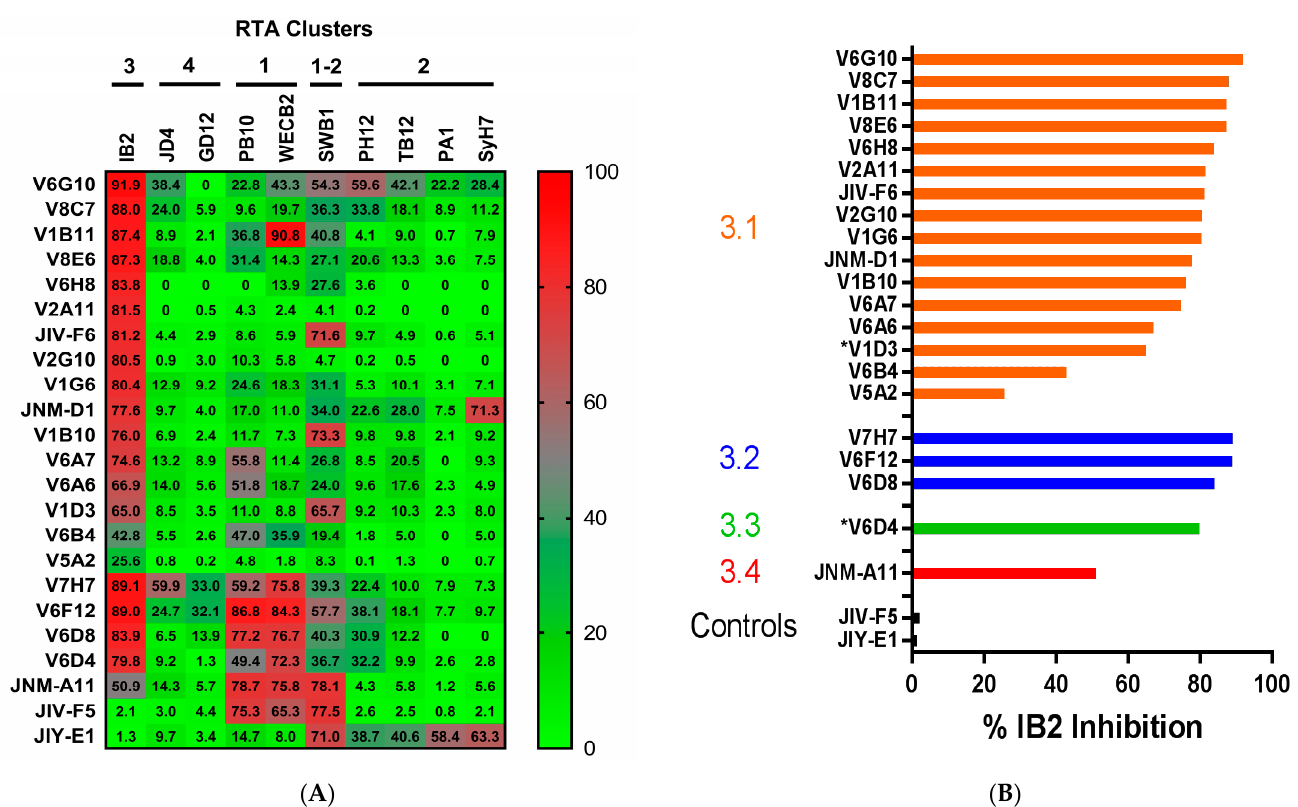
Figure 2. V H H binning by competition ELISA. ( A ) Ricin was captured on microtiter plates by anti-RTA mAbs (indicated along the top panel) or an anti-RTB mAb (SylH3) as a control. The plates were then probed with individual V H Hs as indicated on the left most column and detected with a secondary E-tag antibody. Binding inhibition was calculated as 100 − (100 × (A mAb-Ricin /A SylH3-Ricin )) where interference by SylH3 was assumed to be negligible. The colored scale bar on far right indicates % inhibition. V H Hs JIV-F5 and JIY-E1 were used as controls, since they are known to bind epitopes on RTA outside of IB2’s footprint. ( B ) The IB2 values from panel A are re-plotted for clarity to compare relative IB2 inhibition values and color coded based on subcluster designations described later in the manuscript. The two V H Hs with toxin-neutralizing activity are denoted with an *.